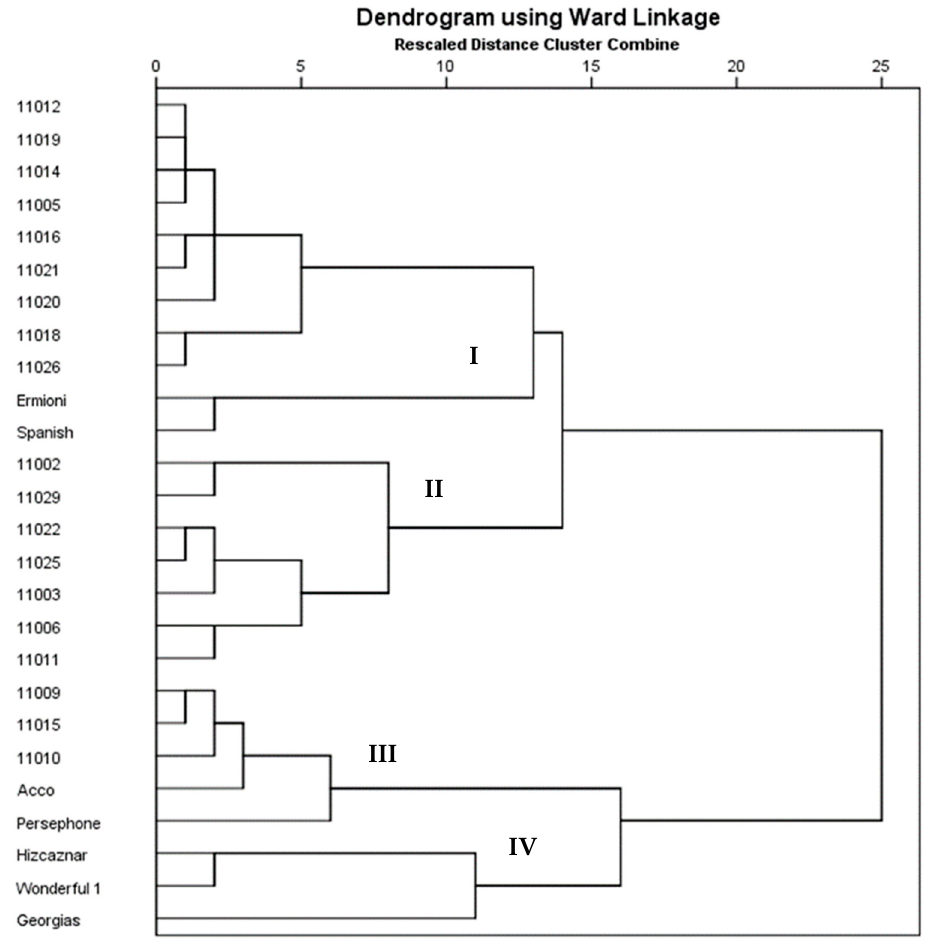
Figure 2. Cluster analysis of the studied 26 pomegranate genotypes based on phenotypic traits.